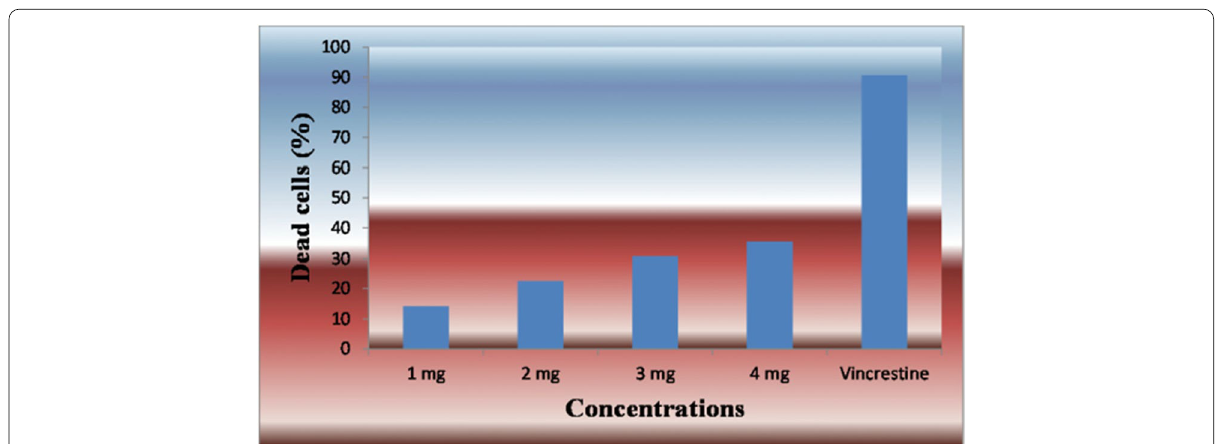
Fig. 14 Effect of different concentrations of xylooligosaccharides (1.00, 2.00, 3.00, and 4.00 mg/ml) on the viability of EACC compared with